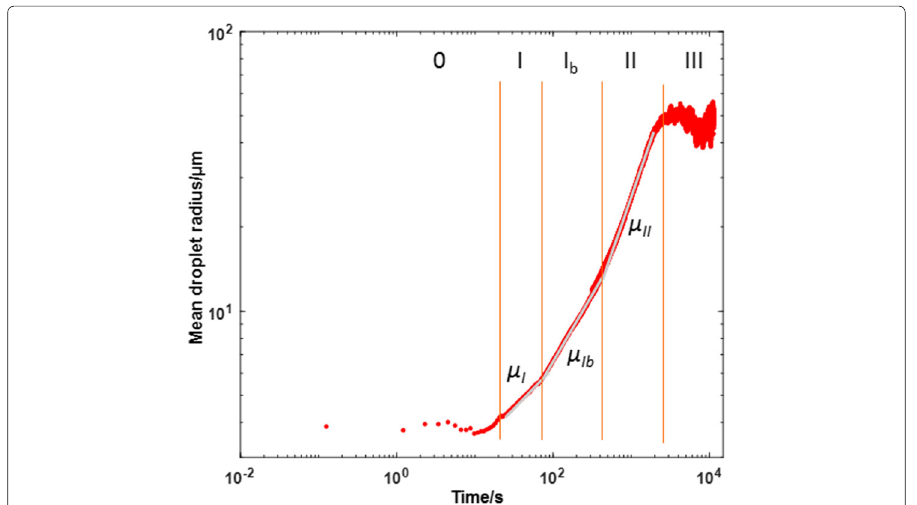
Fig. 5 Mean droplet radius as a function of time for the 45% relative humidity. 0, I, I b , II and III describe the different